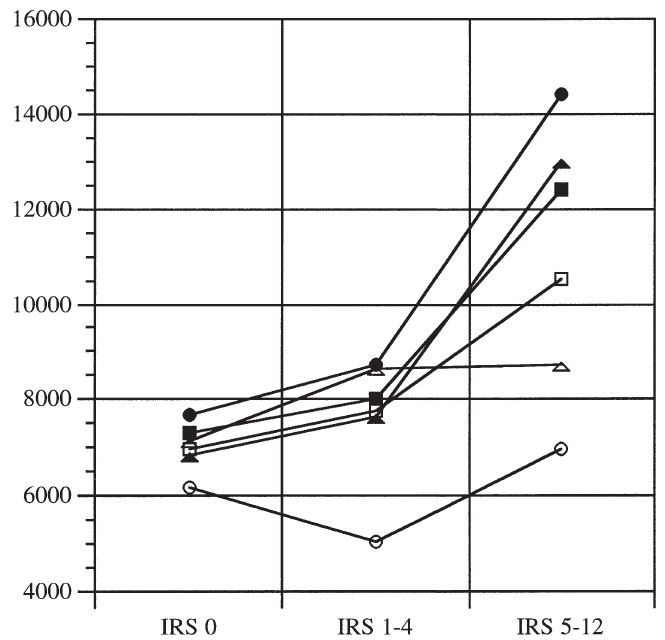
Fig. 2. Standard deviation of the integrated optical density in breast cancers with different p53 expression in correlation to DNA ploidy, S-phase and G2M-fraction. IRS 0 . . . p53 negative tumours; IRS 1–4 . . . weakly p53 positive tumours; IRS 5–12 . . . strongly positive tumours. 1 peri-, di- and tetraploid; 2 aneuploid; ! S-phase < 5%; " S-phase > 5%; P G2M-fraction < 5%; Q G2M-fraction > 5%.